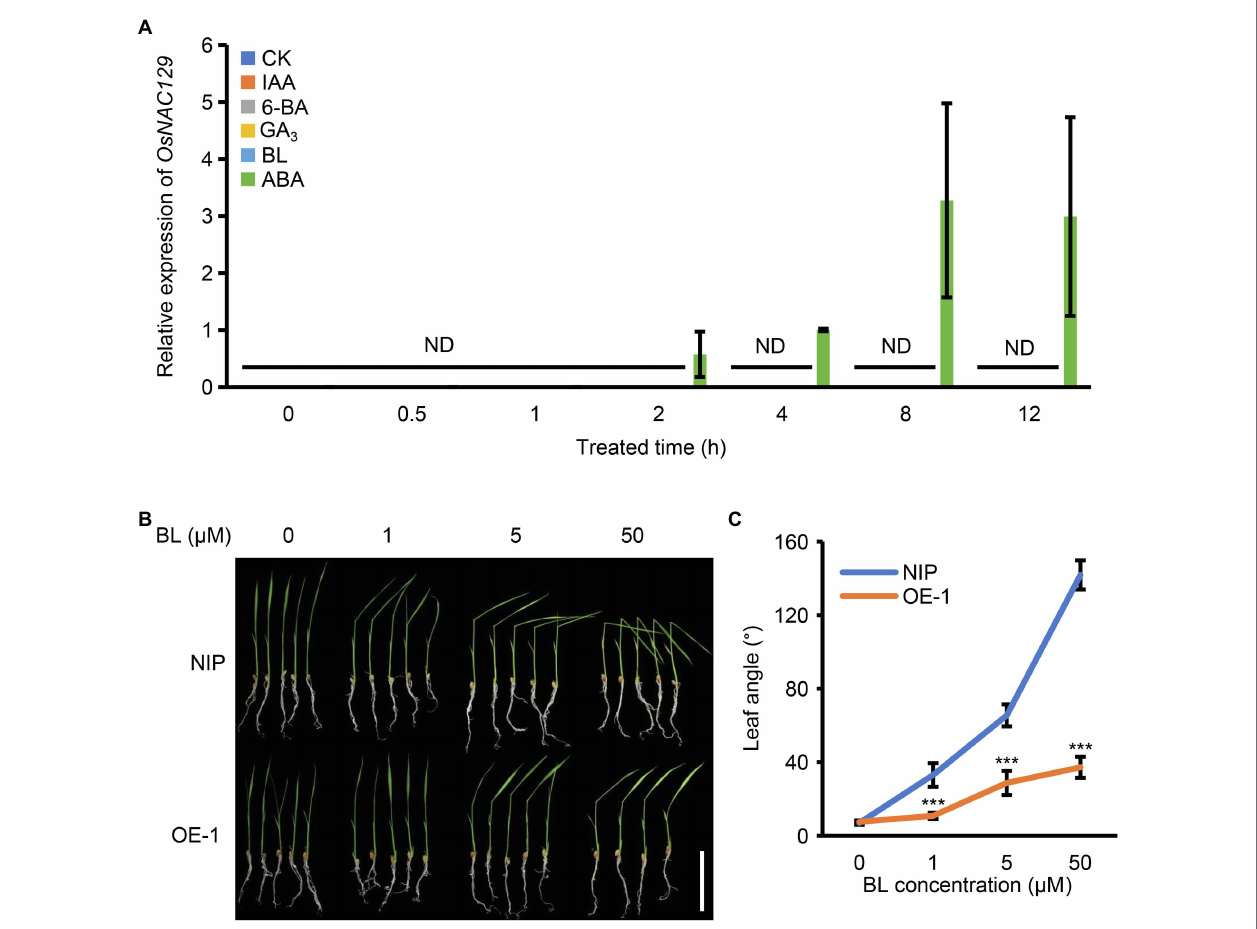
FIGURE 5 | OsNAC129 is an abscisic acid (ABA)-inducible and brassinolide (BR)-related gene. (A) OsNAC129 was exclusively induced by ABA. About 1-week-old NIP seedlings were treated separately with IAA, 6-BA, GA 3 , BL, and ABA (50 μ M of each phytohormone), and sterile water treatment was the control. Samples were collected, RNA was extracted, and the expression of OsNAC129 was determined by qRT-PCR. Data are means ± SD of four replicates. ND, not detected. (B) About 2-week-old seedlings of WT and the OsNAC129 -OE-1 line were treated with three concentrations of BL for 24 h, after which the leaf angles were imaged. Scale bar = 5 cm. (C) Leaf angles of WT and OE-1 seedlings measured by Image J after BL treatment. Data are means ± SD of 10 replicates. *** p < 0.001 as determined by Student’s t